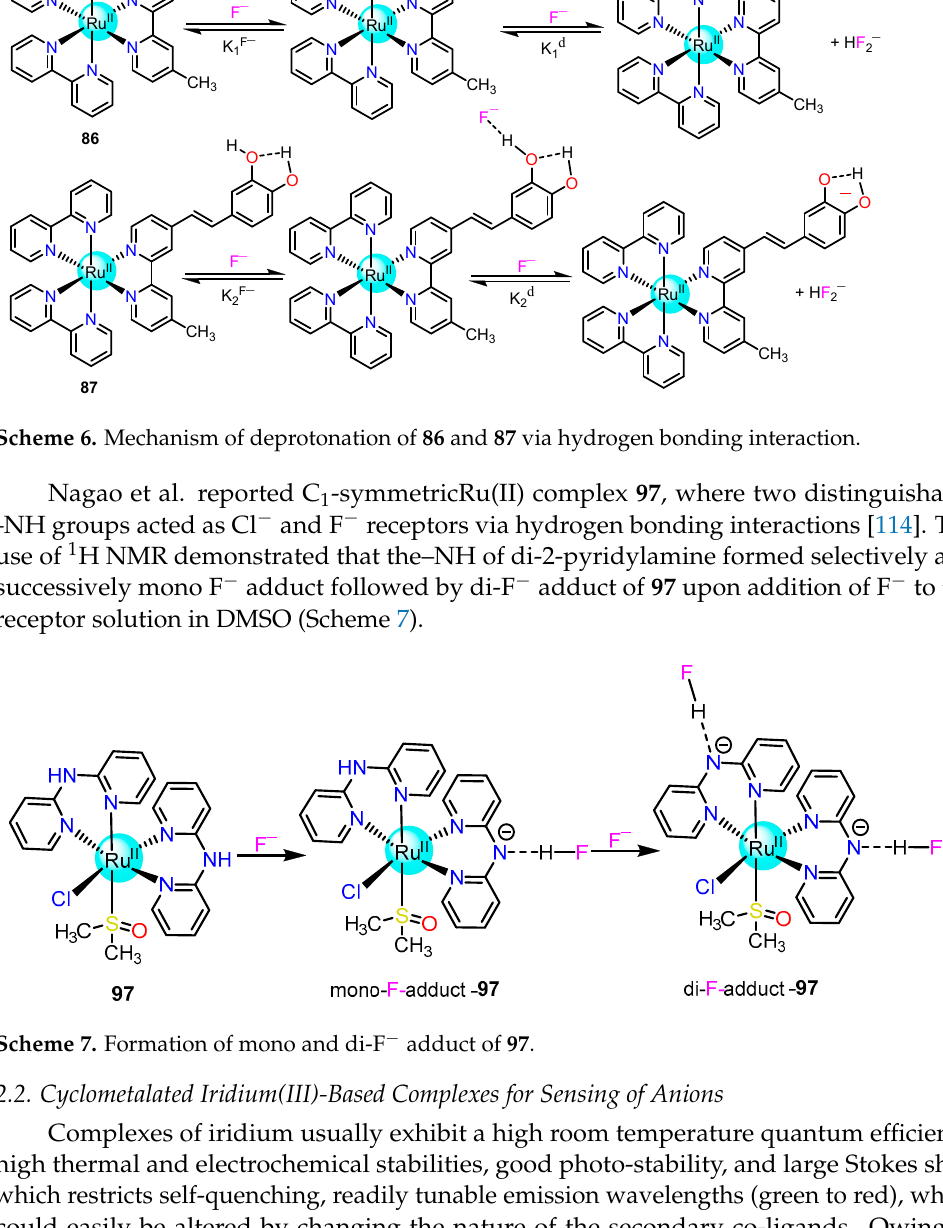
Scheme 6. Mechanism of deprotonation of 86 and 87 via hydrogen bonding interaction.